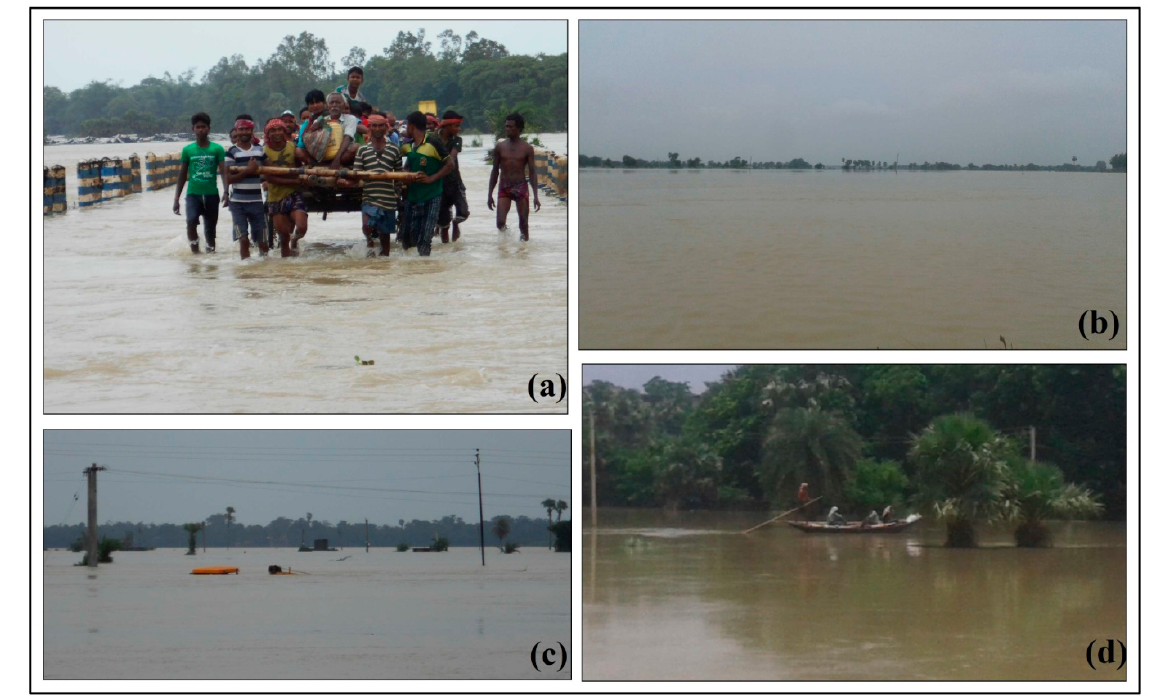
Figure 3. Field photographs showing flood inundation area in the present study area: ( a ). Concrete bridge under the water (23°48 ′ 20.26 ′′ N, 87°49 ′ 10.67 ′′ E), ( b ). Flooding in the large area (23°52 ′ 13.74 ′′ N, 88°2 ′ 45.89 ′′ E), ( c ). Car and houses flow with flooding water (23°50 ′ 25.01 ′′ N, 87°58 ′ 4.20 ′′ E), ( d ). Local boat is the main medium of communication during flooding (23°55 ′ 17.30 ′′ N, 88°5 ′ 38.22 ′′ E).